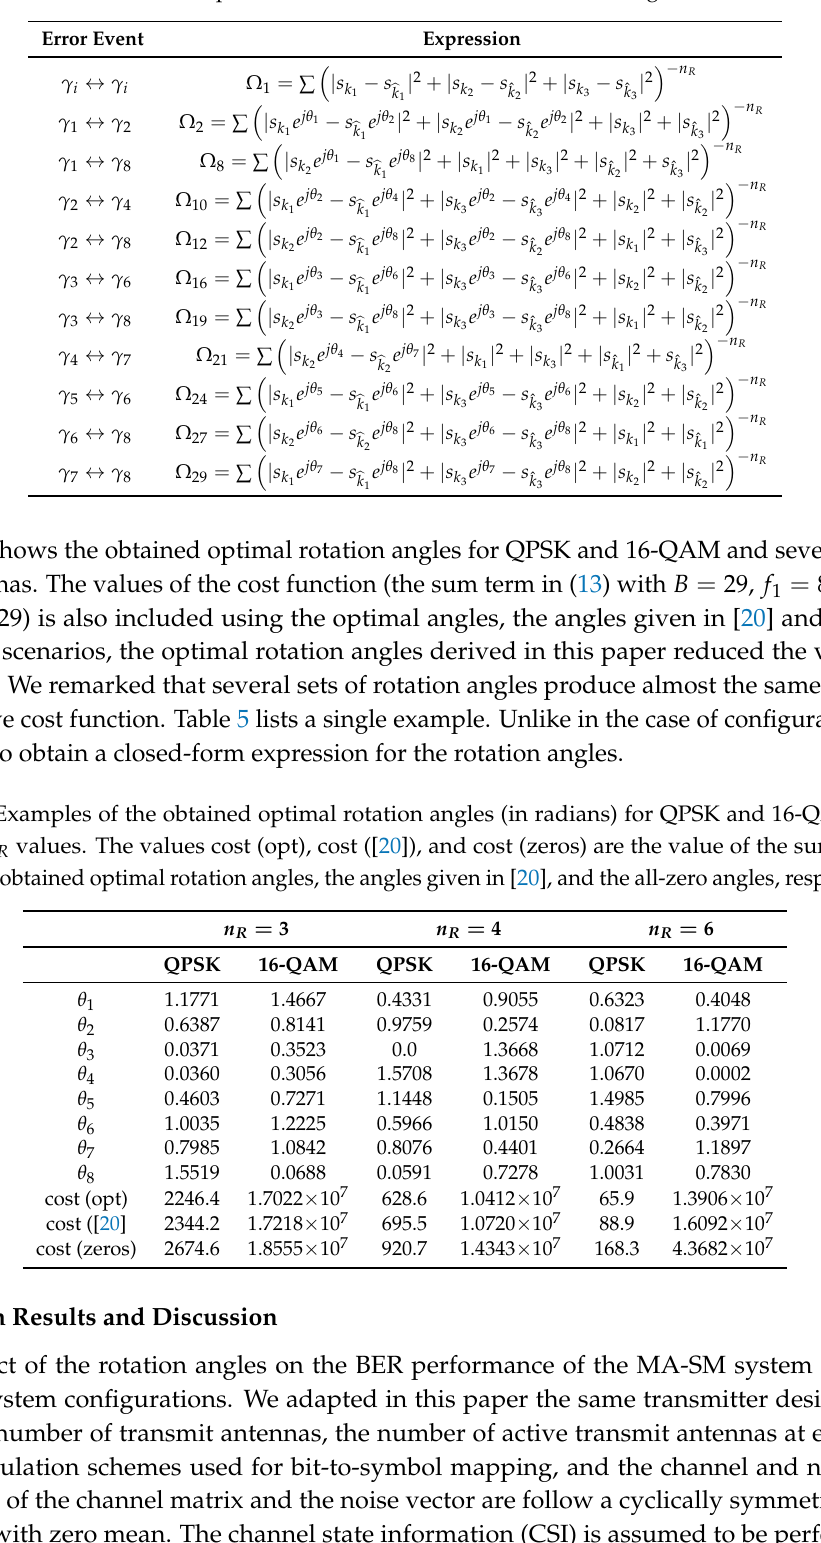
Table 4. Selected partial list of the Ω terms obtained for configuration III.